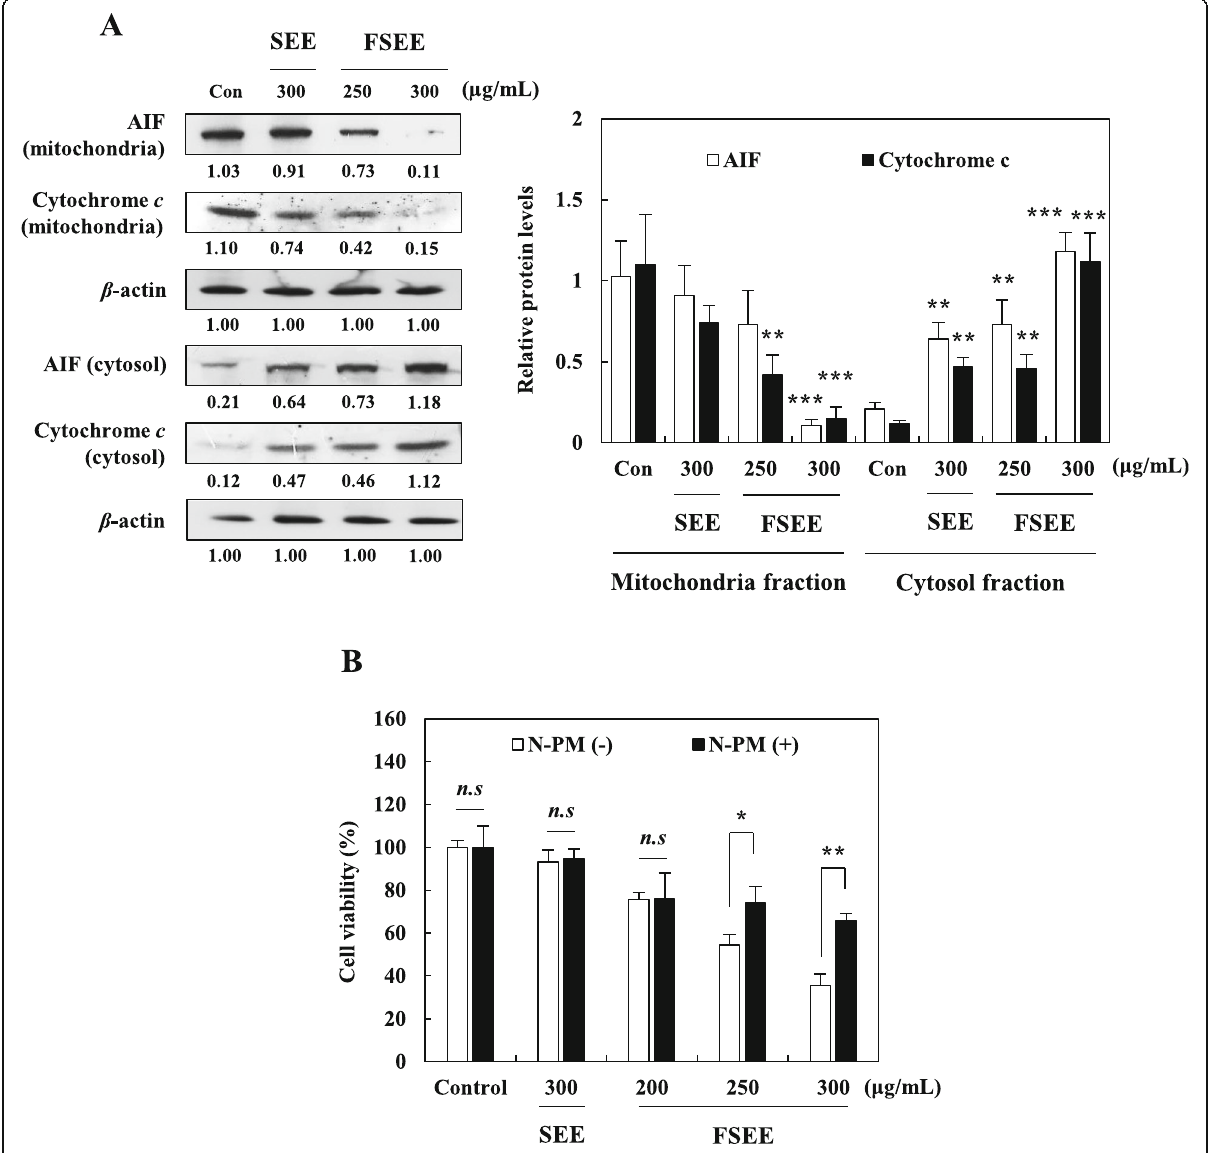
Fig. 5 Effect of SEE, and FSEE on induction of caspase-independent apoptosis in HepG2 cells. Cells were treated with SEE, and FSEE for 24 h. a After 24 h, total cell lysates were subjected to detect expression of apoptosis-related proteins in HepG2 cells. Cells were pretreated with 2 μ M AIF inhibitor (N-PM) for 2 h, and then incubated with 300 μ g/mL of SEE, and 200 – 300 μ g/mL of FSEE for 24 h. b Effect of the AIF inhibitor on SEE,